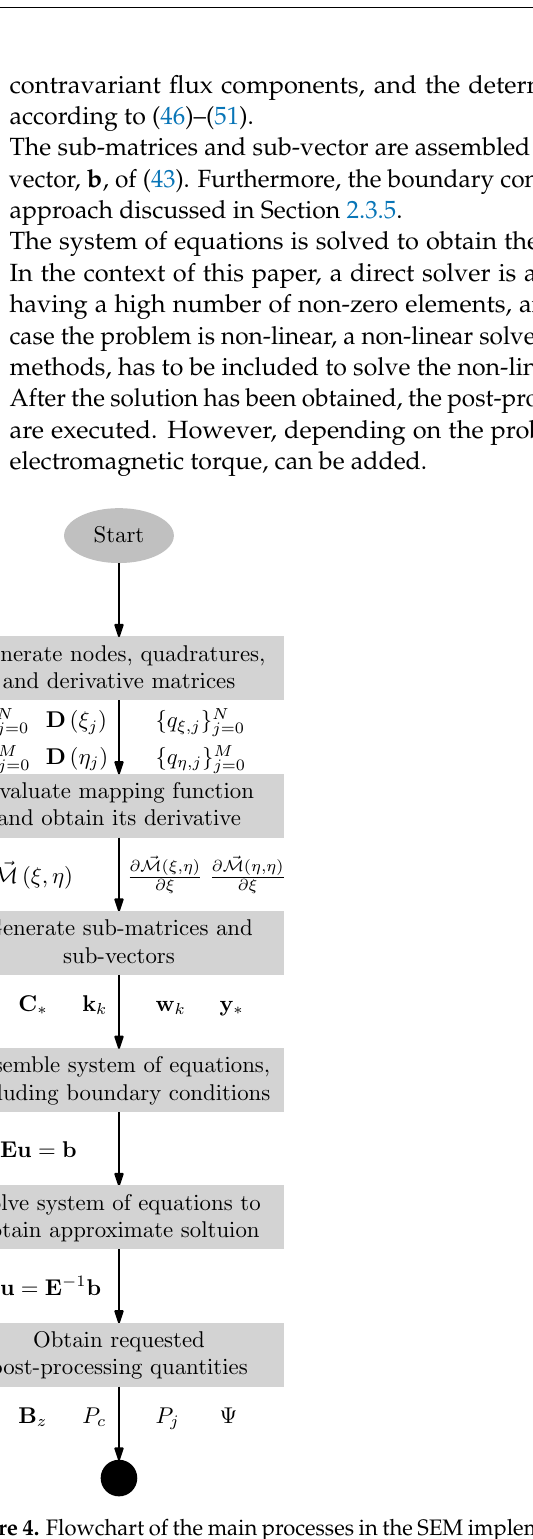
Figure 4. Flowchart of the main processes in the SEM implementation for an electromagnetic